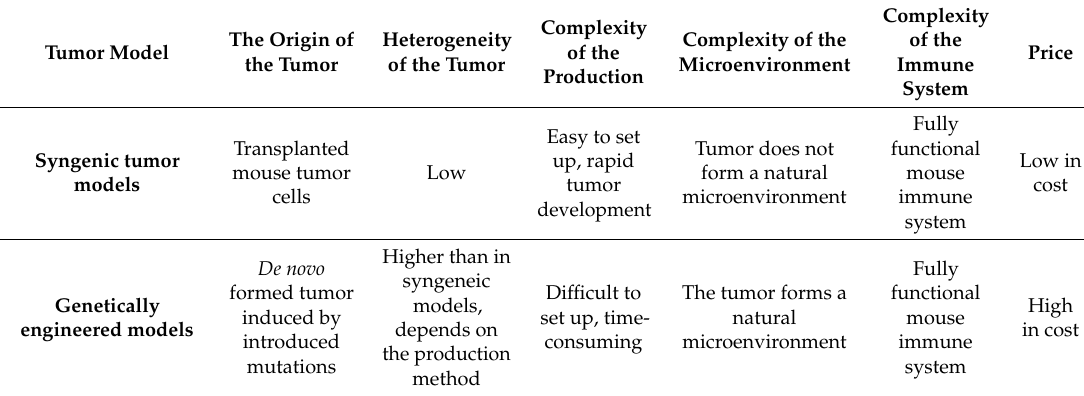
Table 1. Comparative characteristics of mouse tumor